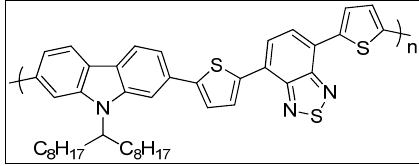
Figure 22. Molecular structure of PCDTBT.